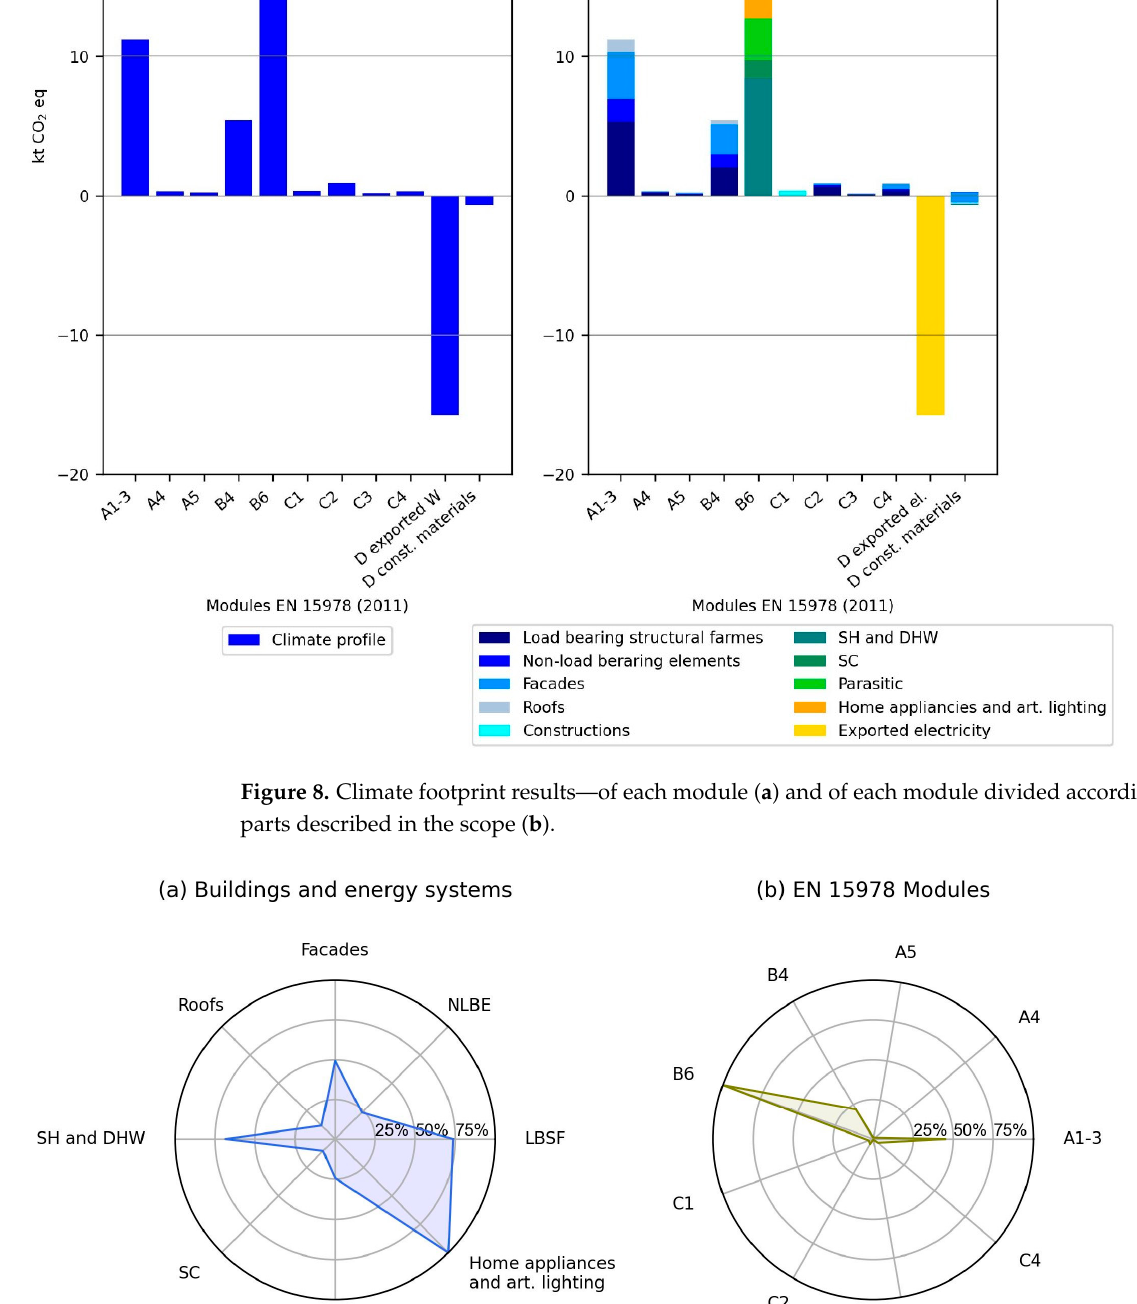
Figure 10. Climate footprint of the district as a function of time concerning four different scopes— without purchase of RECs ( a ) and with purchase of RECs ( b ). The results obtained were consistent, as an average, with what was found in previous studies. For embodied and operational emissions, the order of magnitude was in line with Asdrubali et al., Causone et al. [1] (average of the two assessments given), and Rasmussen et al. These three studies were selected because they focused on locations in Italy (north, two